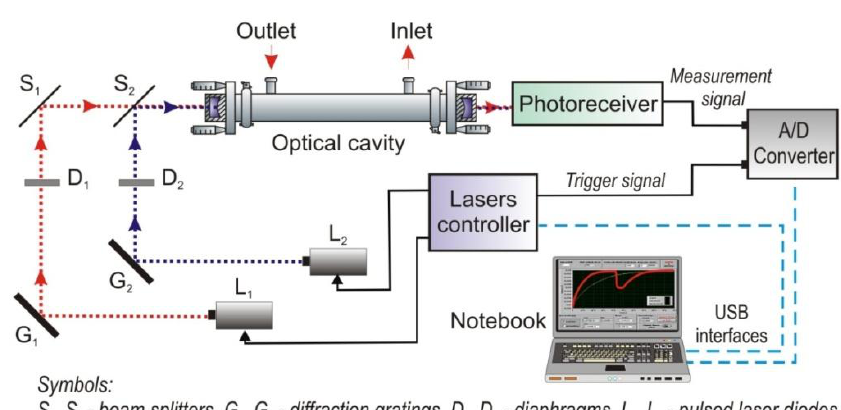
Figure 17. Scheme of two-spectral CEAS